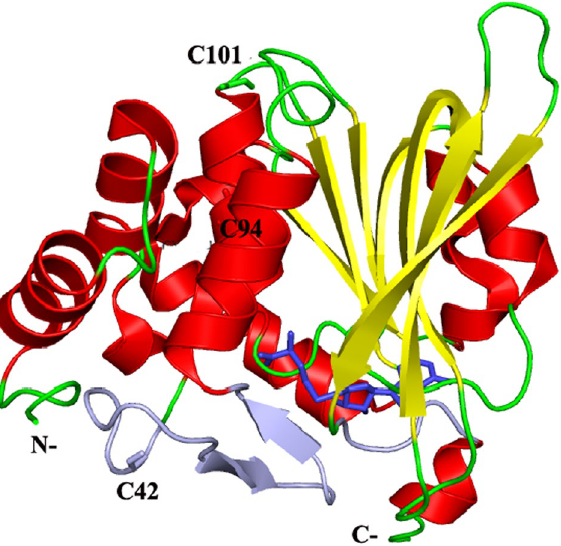
Figure 5. Cartoon representation of human PIMT structure, with the secondary structures, helix (red), sheet (yellow) and loop (green), shown in different colors, and the cofactor (S-adenosyl homocysteine) shown in stick model, based on the PDB file, 1I1N). The N- and C-termini of the polypeptide chain, as well as the three Cys residues in the protein are labelled. The regions lining the binding site, and towards the exterior of the molecule, are indicated in light violet—these include residues Thr57-Ser59 and Tyr212-Thr216. (As in some structures the residues upstream of the former region are found to be rather flexible or disordered, the entire stretch, Lys41- Ser59 has been